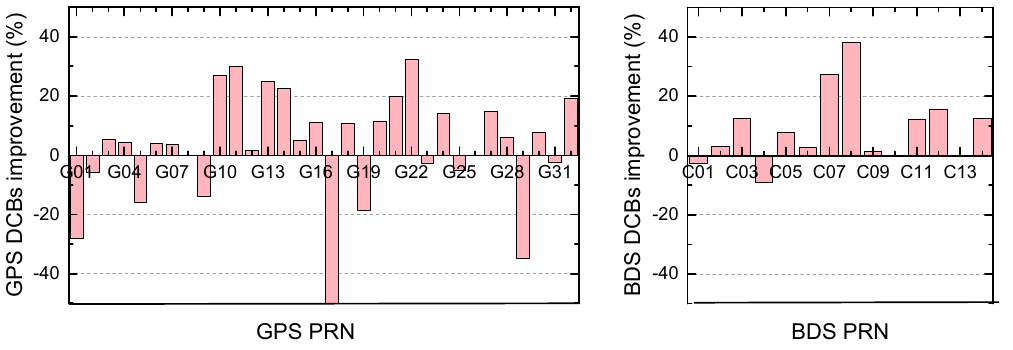
Figure 5. GPS and BDS satellite DCB stability improvement of L4-cor solution against the L4-raw solution.